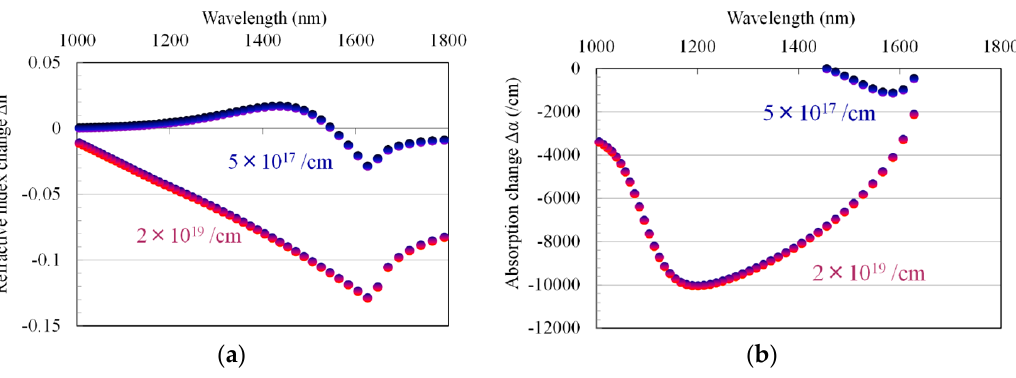
Figure 7. Variation in refractive index ( a ) and absorption coefficient ( b ) of Ga 0.47 In 0.53 As as functions of wavelength of light, with carrier density as a parameter.